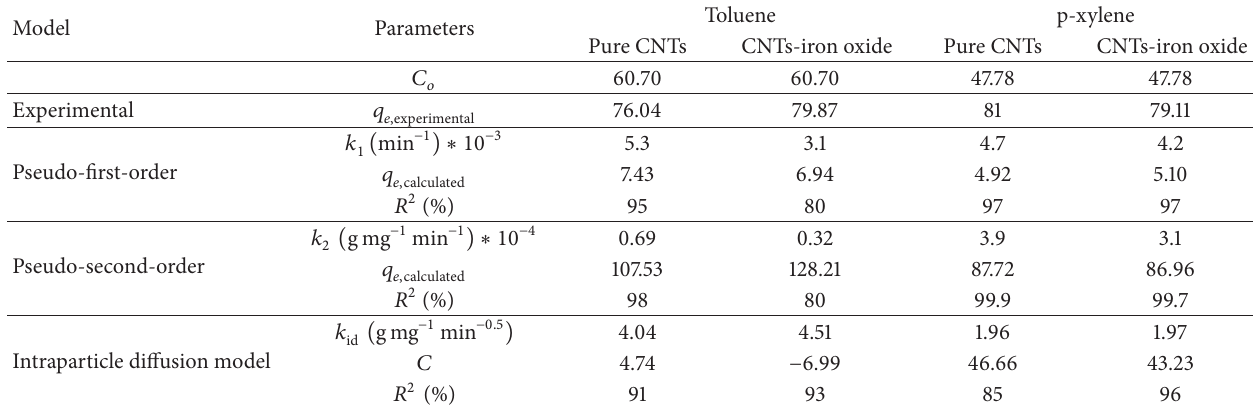
Table 2: Adsorption kinetics parameters of toluene and p-xylene adsorption.